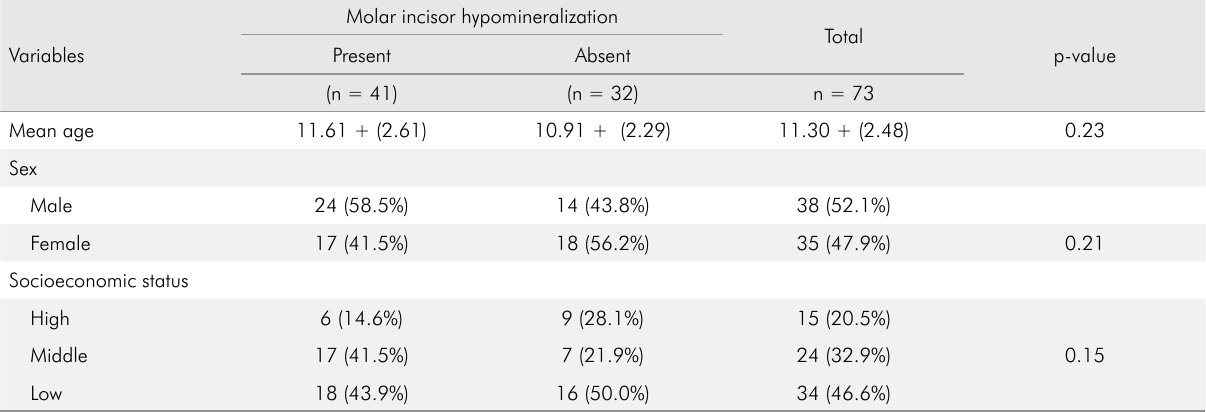
Table 1. Sociodemographic variables of patients who presented for clinical care.